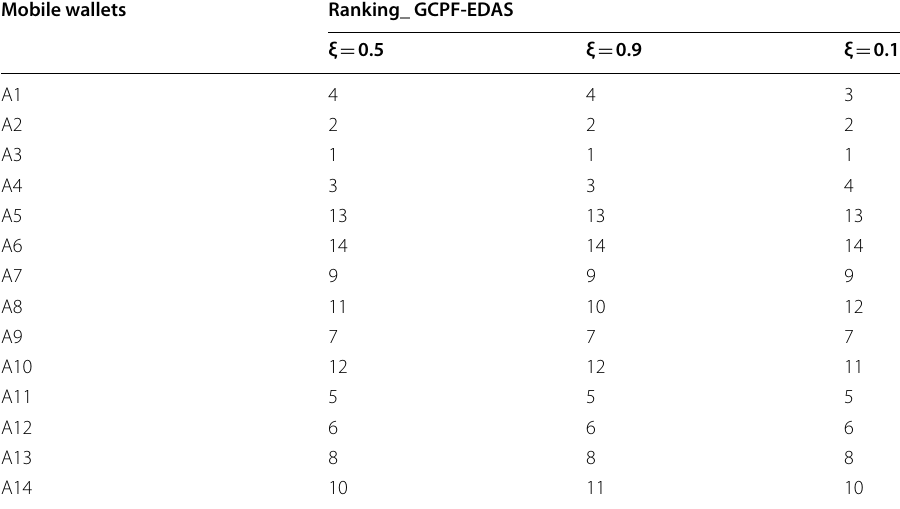
Table 18 Comparison of ranking orders (sensitivity analysis with varying ξ) Mobile